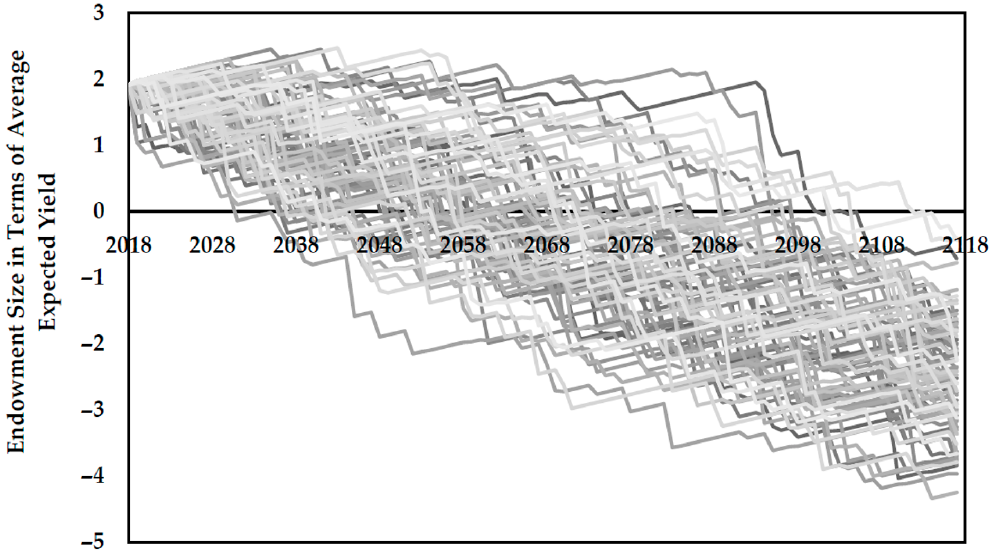
Figure 8. Size and fluctuation of annual endowment for 100 stochastic simulations with 3% premium; initial endowment is 1.8 AEY.